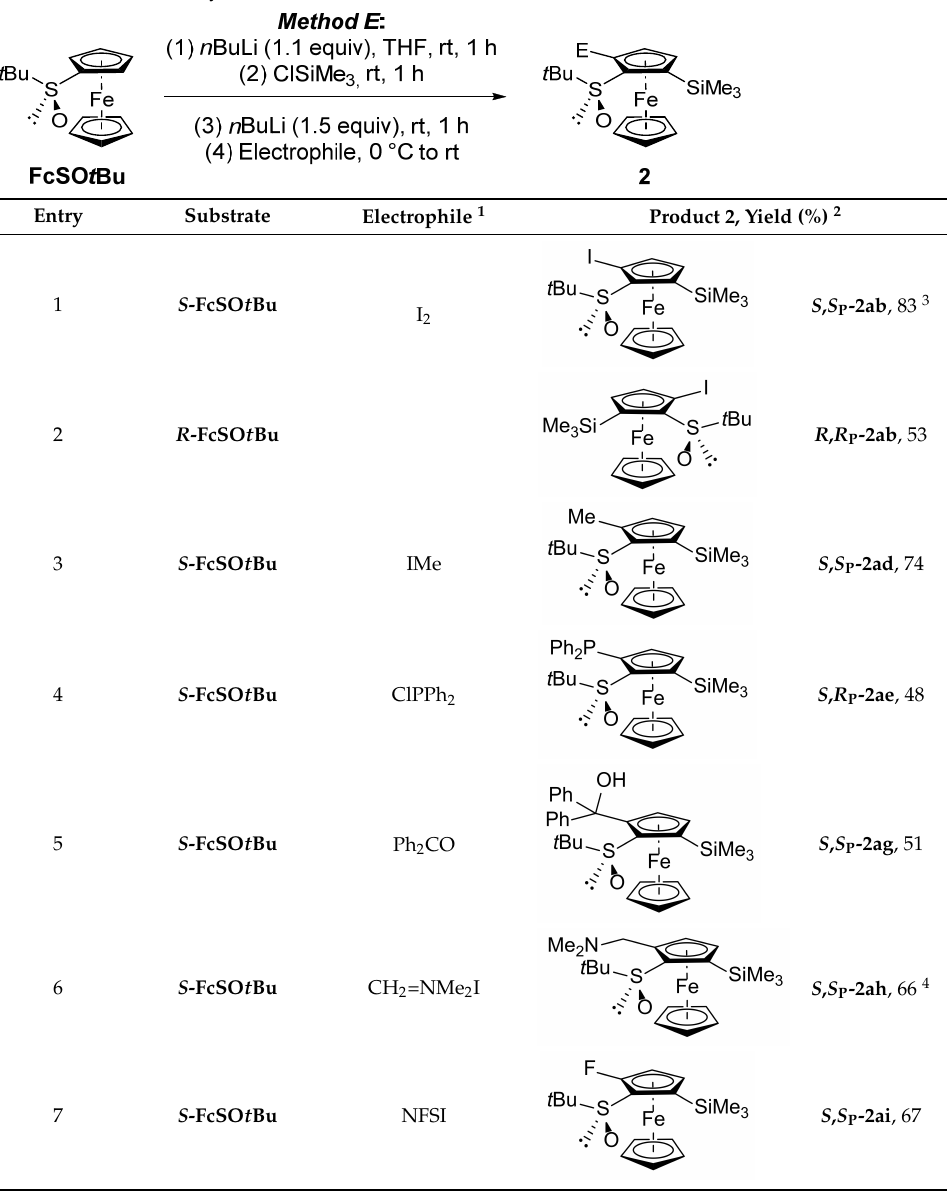
Table 4. One-pot deprotolithiation-trimethylsilylation-deprotolithiation-electrophilic trapping se- quence from S - tert -butylferrocenesulfoxides.